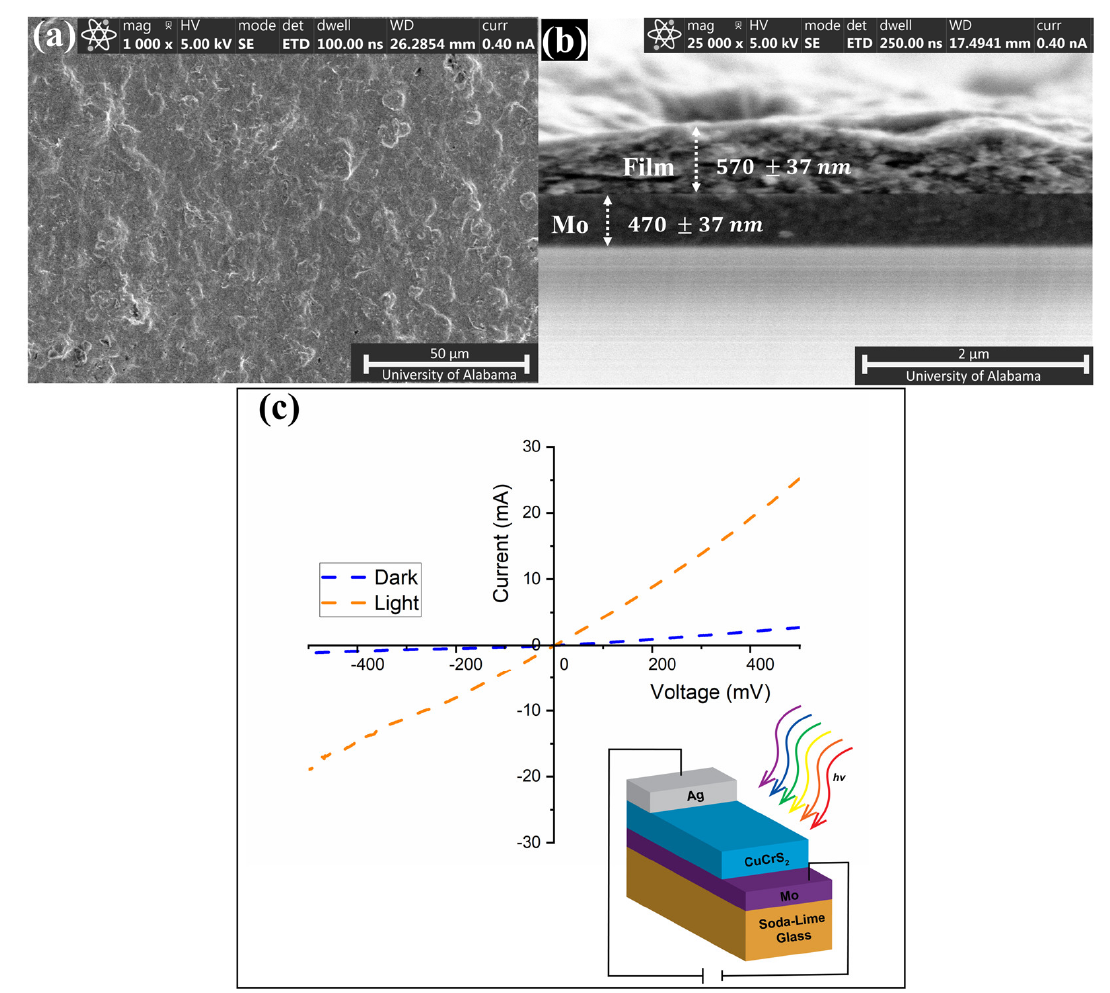
Table 1. Photocurrent and responsivity of CuCrS 2 thin film electrode.